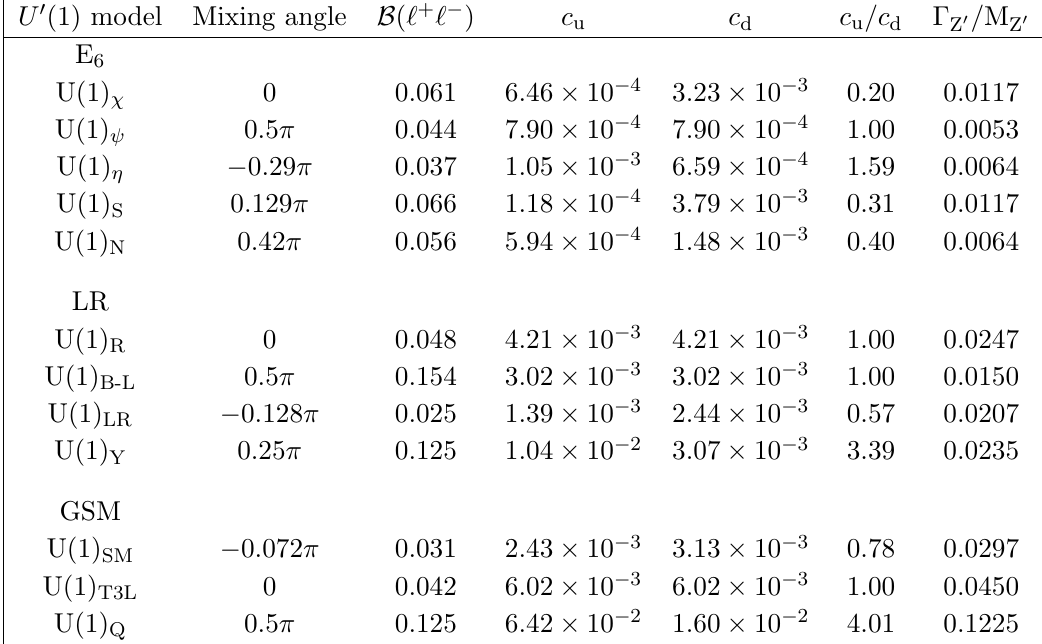
Table 1 . Various benchmark models with their corresponding mixing angles, their branching fraction ( B ) to dileptons, the c u and c d parameter values and their ratio, and the width to mass ratio of the associated Z 0